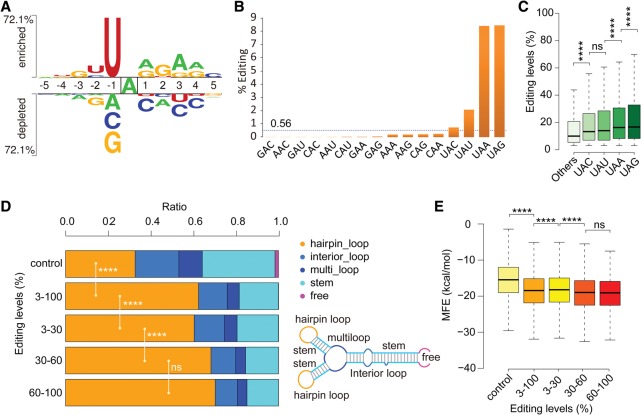
Sequence and structure preferences of the A-to-I editing sites in F. graminearum. (A) Two Sample Logo showing the enriched (above the top line) and depleted (below the bottom line) nucleotides nearby the A's targeted for RNA editing (P < 0.01, t-test), with the level of preference or depletion proportional to the scale. A total of 30,000 adenosine sites randomly chosen from predicted cDNA sequences were used as the negative control. (B) The percentage of marked triplet sequences with A-to-I editing events. For each of the 16 possible triplets centered on the edited adenosine (NAN), the number of observed editing events was divided by its total occurrence in cDNA sequences. The horizontal dotted line marks the average percentage (0.56%) of editing events observed in these 16 NAN triplets. (C) Box plot comparing the editing levels of editing sites in different triplets: (****) P < 0.0001, t-test; (ns) not significant. (D) Stacked column showing the ratio of RNA editing events of marked editing levels in the five types of RNA secondary structure elements diagrammed on the right. The predicted RNA secondary structure is based on 30-nt upstream and 30-nt downstream sequences surrounding the edited A's. The statistical significance for hairpin loop ratio comparison is indicated: (****) P < 0.0001, χ2-test; (ns) not significant. (E) Box plot showing the minimum free energy (MFE) of predicted hairpin loops with A-to-I editing events of different editing levels. The statistical significance for each comparison is indicated: (****) P < 0.0001, t-test; (ns) not significant.